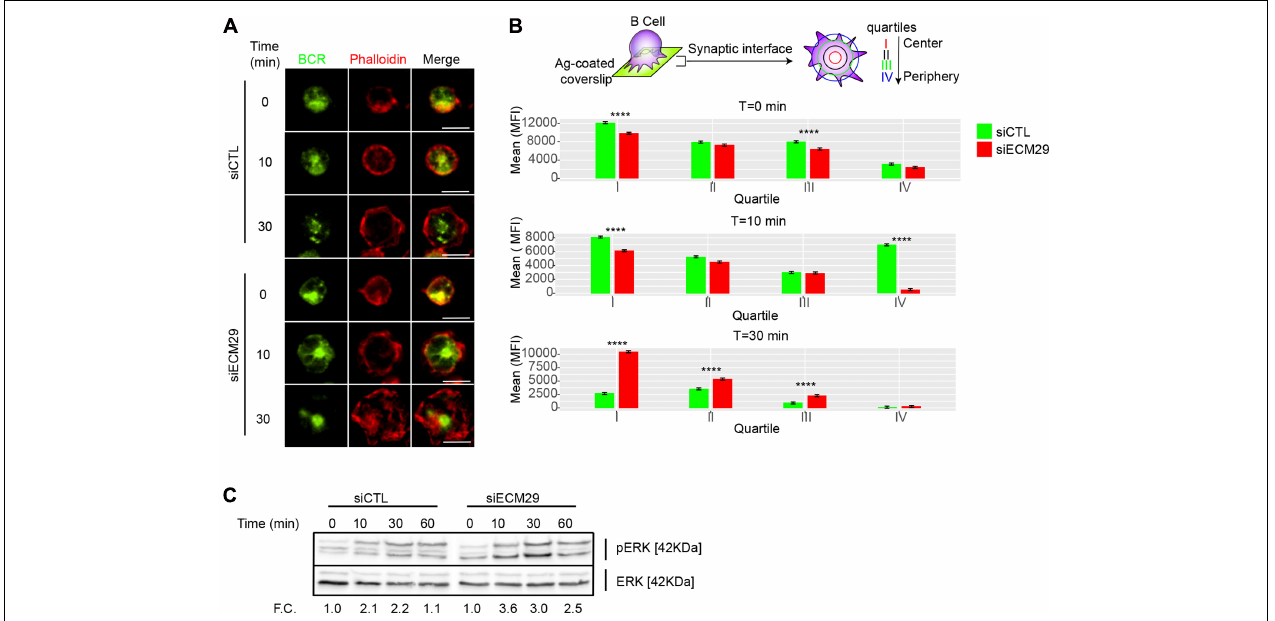
FIGURE 5 | Ecm29 silencing enhances BCR clustering and Erk phosphorylation: (A) Representative Epifluorescence images of control (siCTL) and Ecm29-silenced (siECM29) B cells, activated onto antigen-coated coverslips for different time points (0, 10, and 30 min), labeled for the BCR and F-actin (phalloidin). (B) Schematic representation of BCR distribution quantification, and the respective quantification of BCR accumulation in each quartile of the immune synapse in B cells shown in (A) . N = 2. Cells > 30. (C) Immunoblot of protein of control and Ecm29-silenced B cells activated for different time points (0, 10, 30, and 60 min). Phosphorylated Erk (pErk) and total Erk (Erk) are shown. F.C., Fold of change respect time 0 min. **** p < 0.05. Kruskal–Wallis test with Dunn’s test was performed for all statistical analyses. Scale Bar = 10 µ